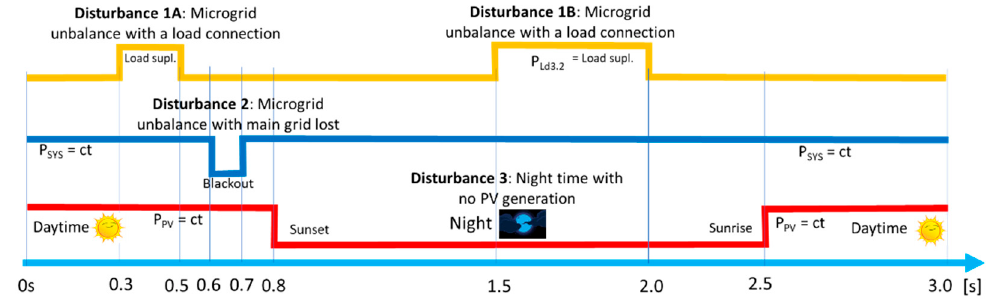
Figure 5. Scenario 2 timeline: applying the three disturbances with overlapped events in order to test more stressful conditions.